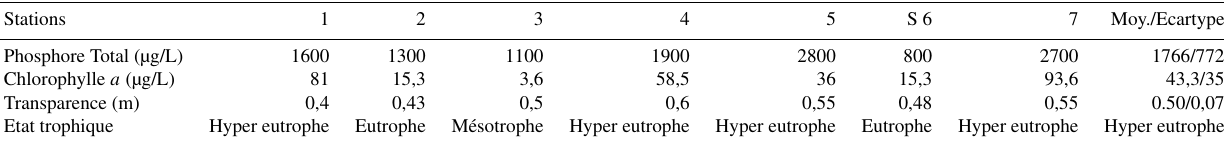
Tableau B3. Niveau trophique (MDDEP, 2004) de la retenue d’eau au mois de juin. Stations